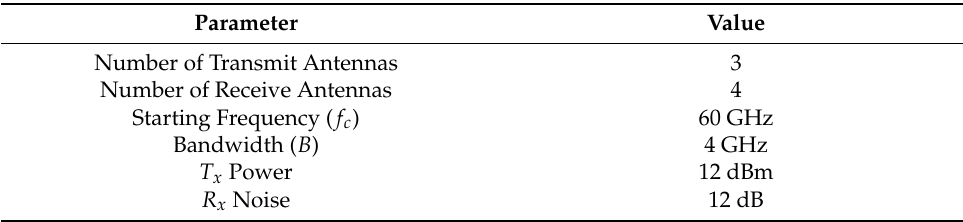
Table 1. Technical specifications of the IWR-6843 TI FMCW radar.